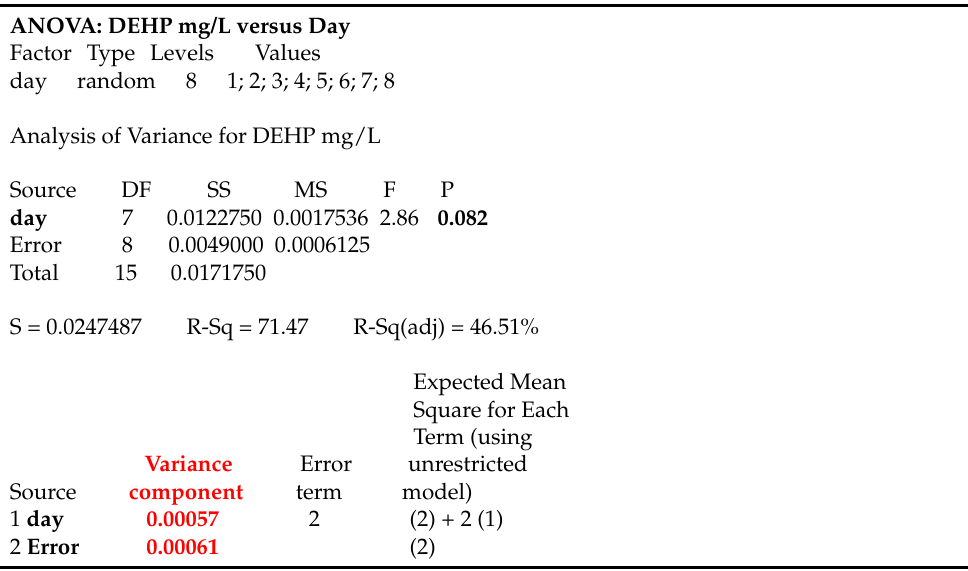
Table 6. Analysis of variance table for estimation of method